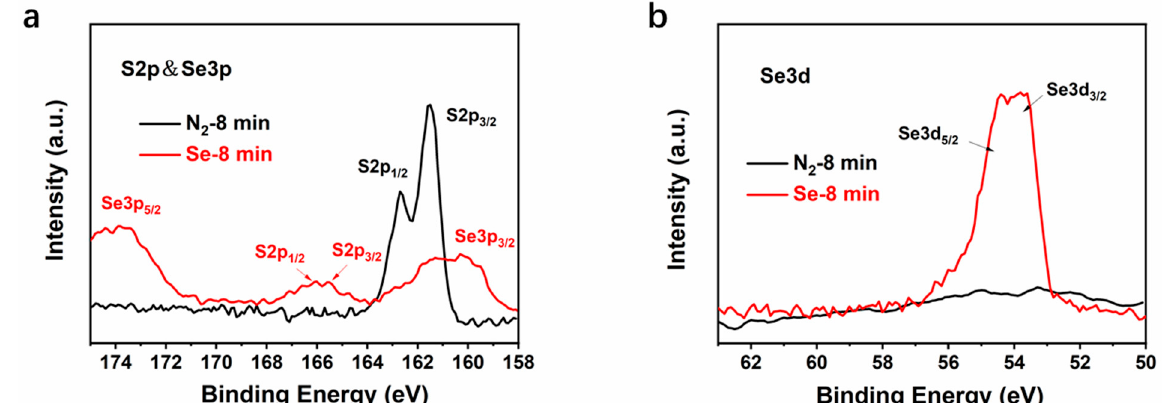
Figure 6. XPS analysis: Core level spectra of ( a ) S2p and Se3p and ( b ) Se3d of CuSbS 2 and CuSbS 2 (Se) selenized for 8 min.